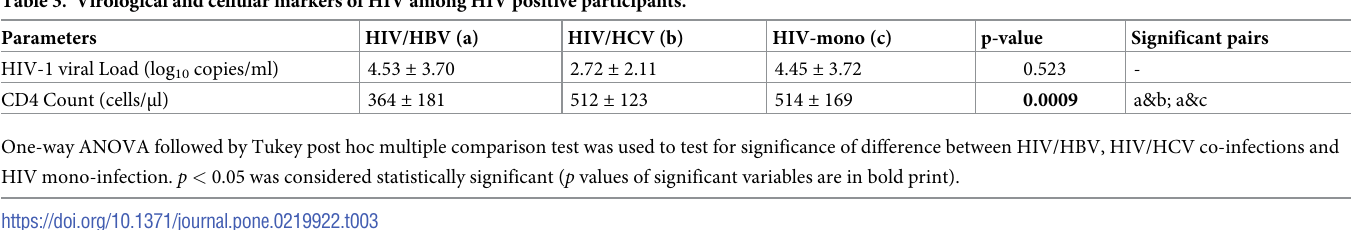
methods for the detection of HCV antibodies, which have higher specificity compared to the